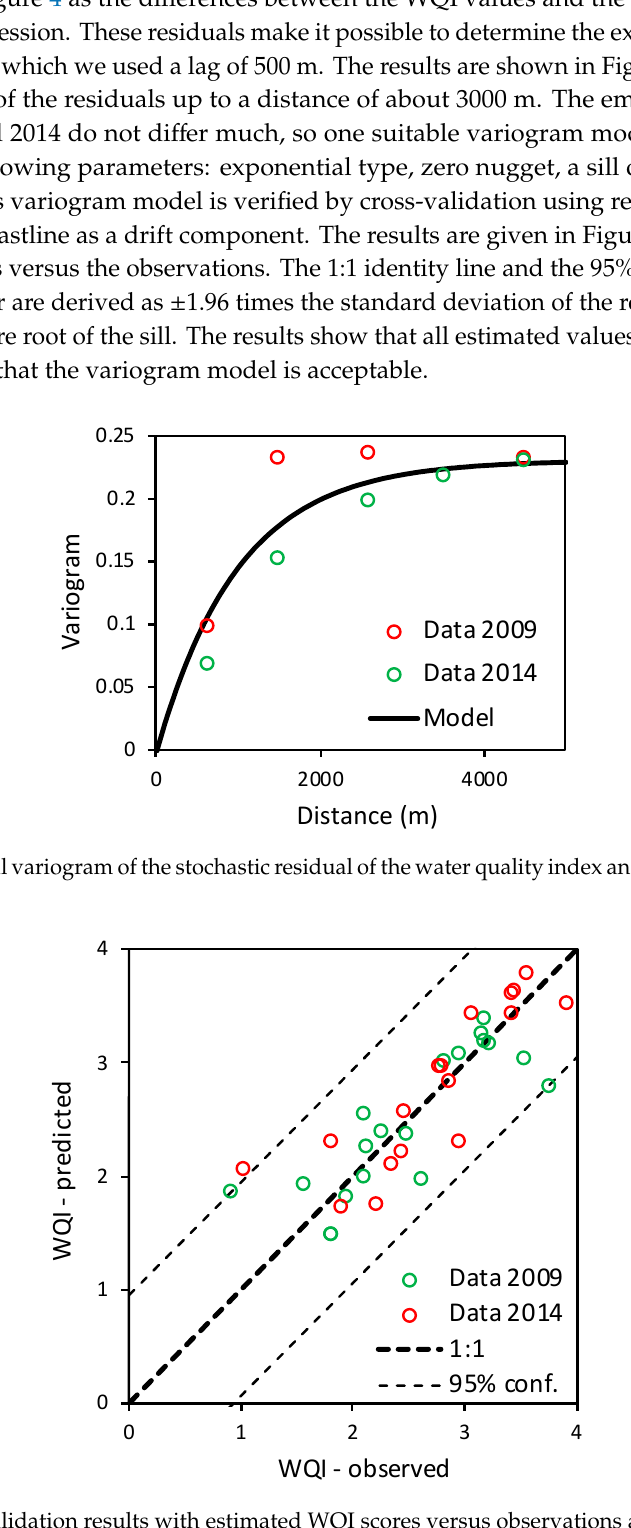
Figure 6. Cross-validation results with estimated WQI scores versus observations and the 1:1 identity line with 95% confidence bands (conf.).